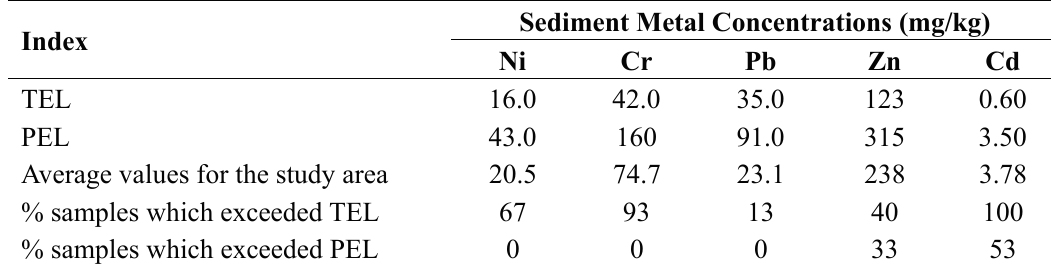
Table 3. Comparison of sediment quality guidelines with average values for the Yanghe